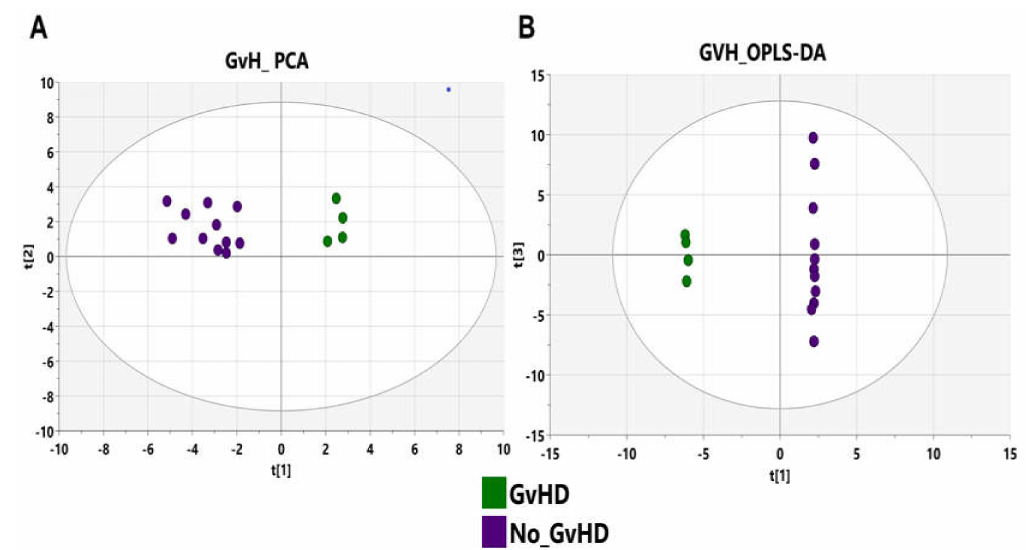
Figure 8. PCA and OPLS-DA score plots of the fecal metabolic profiles from the GvHD and no-GvHD groups. ( A ) PCA score plot model with values of R 2 = 0.596 and Q 2 = 0.476. Green circles represent patients who developed GvHD after the graft and purple circles represent patients without GvHD. ( B ) Orthogonal partial least squares-discriminant analysis (OPLS-DA) score plot model showing separation based on the two extraction methods with R 2 (X) = 0.601, R 2 (Y) = 0.974, Q 2 = 0.923 and cross-validated analysis of variance (CV-ANOVA) p = 0.0256 values. Green circles represent GvHD samples and purple circles represent no-GvHD